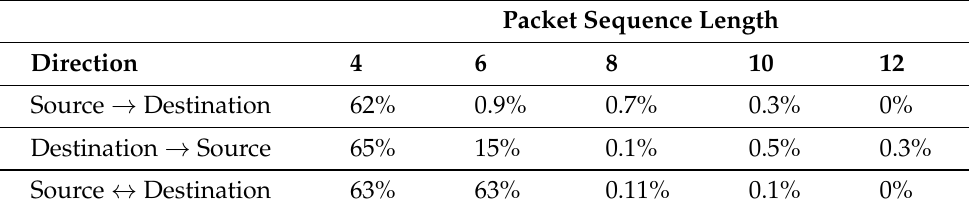
Table 8. Resulting false discovery rate (FDR) of different types of signatures against part of the benign traffic. Signatures are part of the attack samples from the “Reconnaissance” category. The signatures are generated after a combination of packet direction and packet payload size.